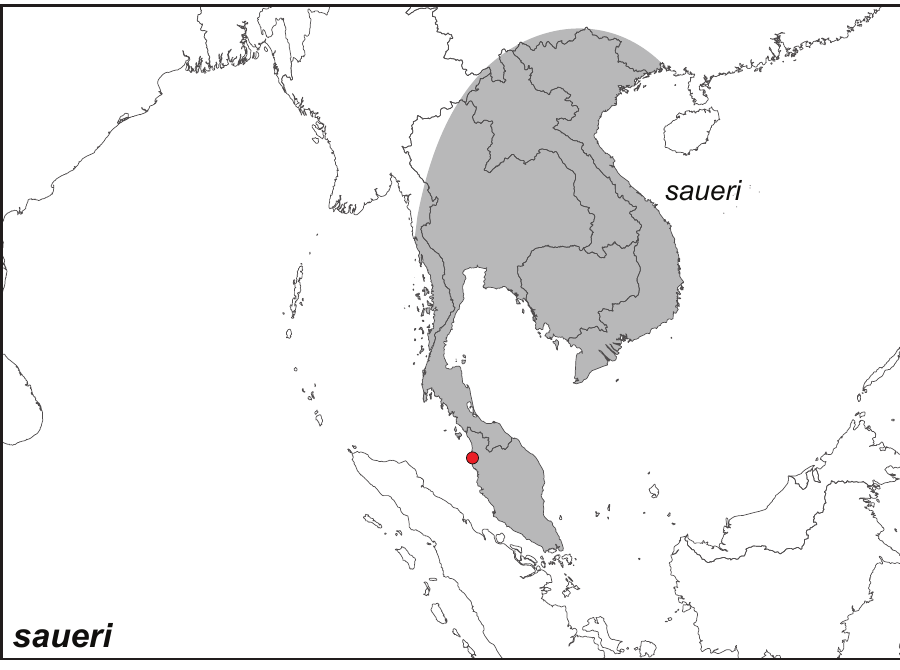
Figure 54. Distribution map of Elymnias saueri